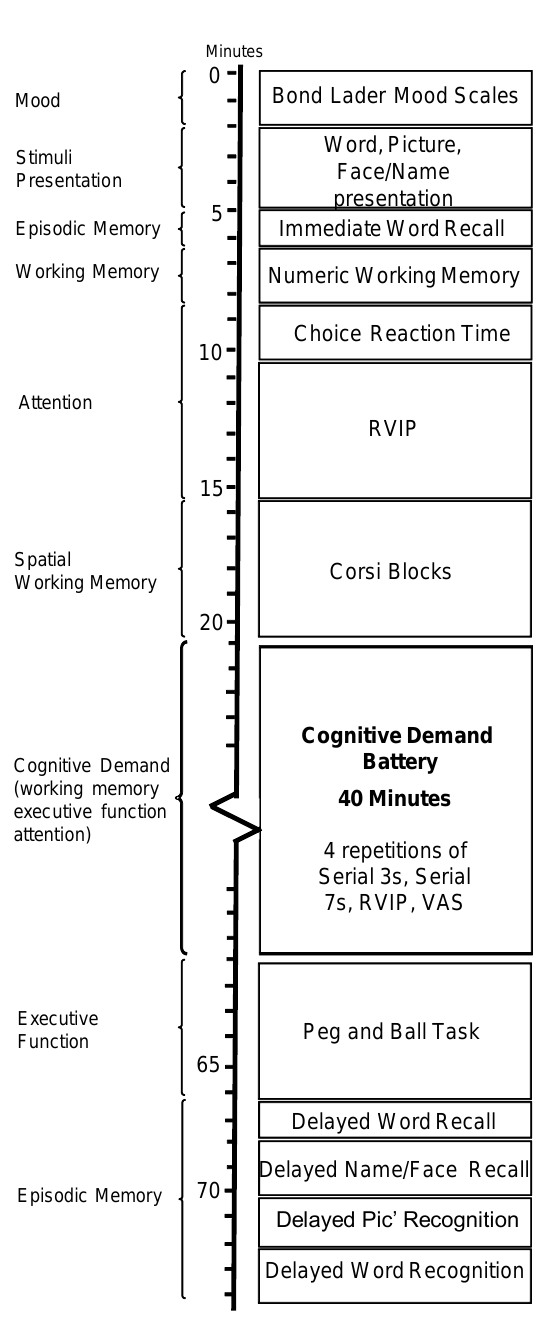
Figure 3. Running order of tasks administered during each assessment.